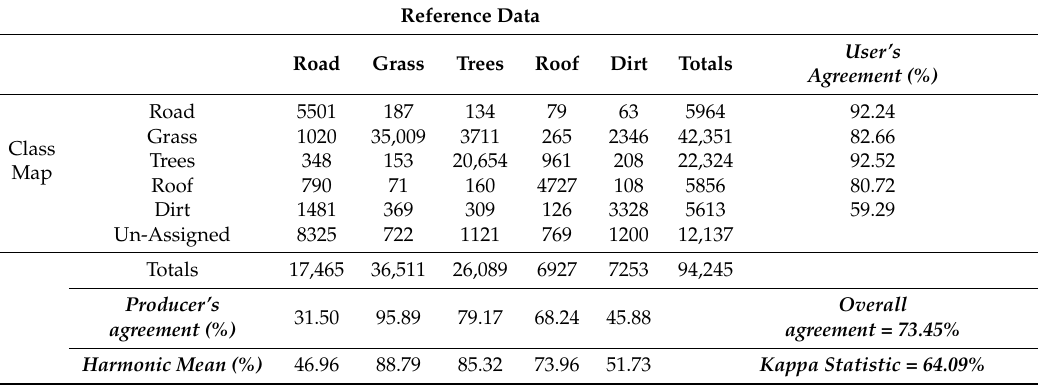
Table 5. Agreement matrix between Full Global and reference map.